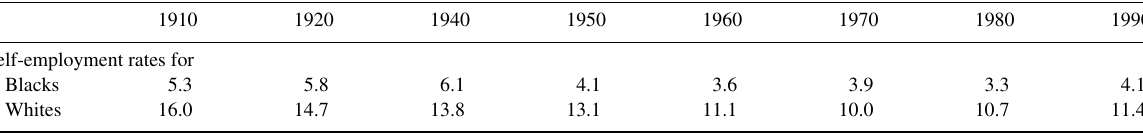
Table 2 United States self-employment rates